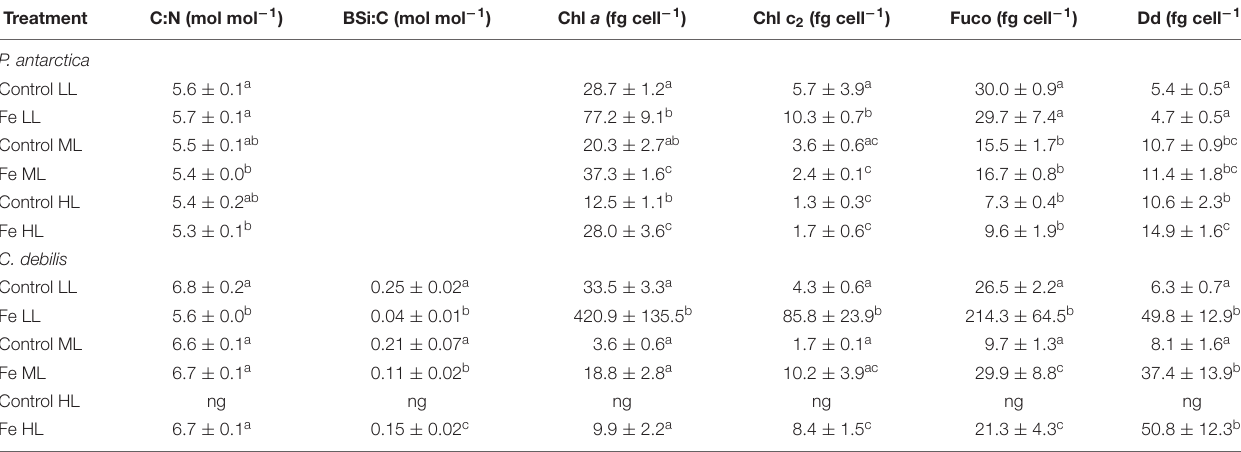
TABLE 1 | Molar ratios of C:N, BSi:C as well as cellular quotas of chlorophyll a (Chl a ), chlorophyll c 2 (Chl c 2 ), fucoxanthin (Fuco), and diadinoxanthin (Dd) were determined for P. antarctica and C. debilis acclimated to control and Fe-enriched conditions combined with low (LL), medium (ML) or high light (HL).